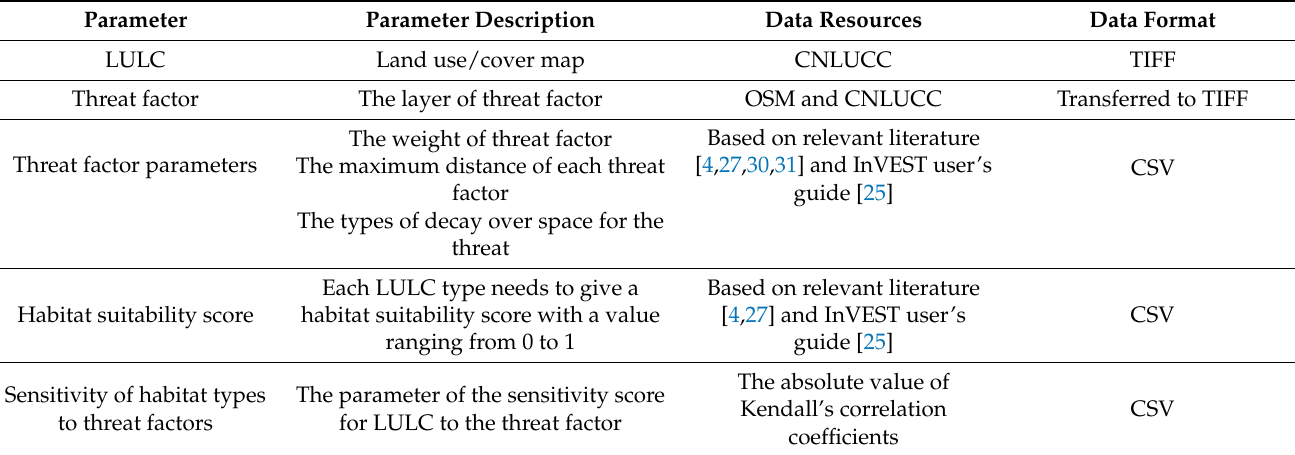
Table 2. The parameters of the habitat quality